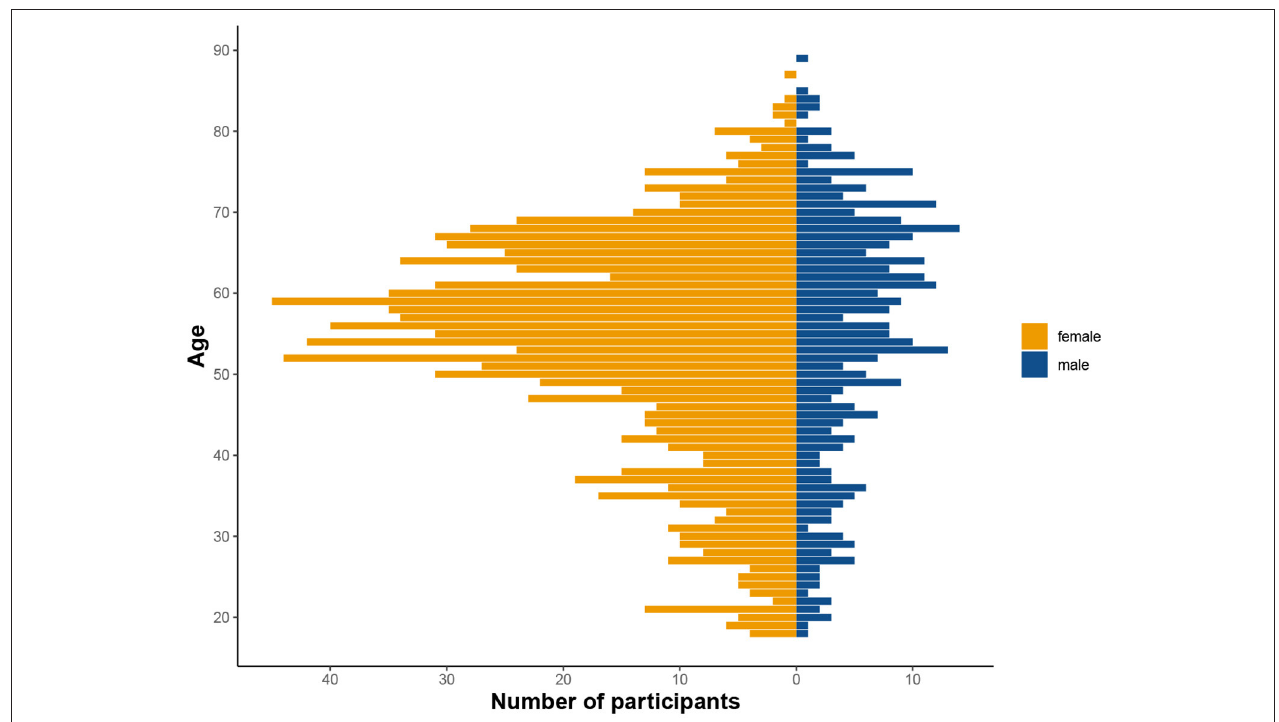
FIGURE 3 | Distribution of age and sex in the tested cohort. Considerably more women than men participated in the study, as is not uncommon in citizen science projects (see Discussion).